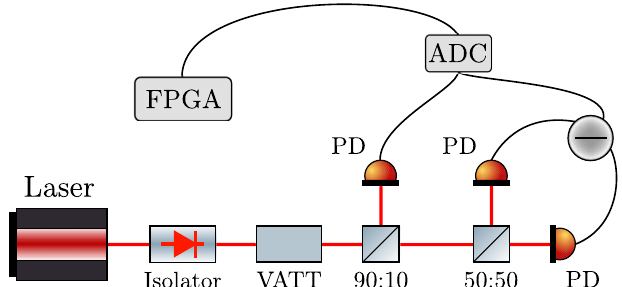
FIG. 2. Schematic of the setup used for random number generation. Measurements generated by the fiber-connected optical elements are fed to an ADC coupled to an FPGA. VATT, variable optical attenuator; PD, photodiode; ADC, analog-to- digital converter; FPGA, field-programmable gate